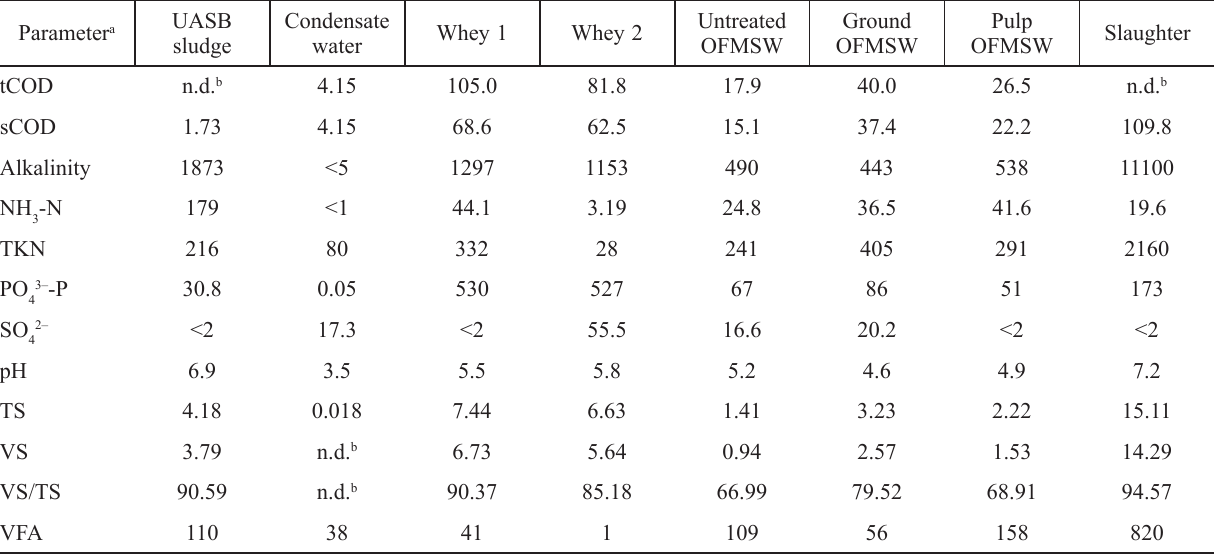
Table 1 – Results of the physicochemical characterization of selected substrates (expressed as mean values; STD<10 %) Parameter